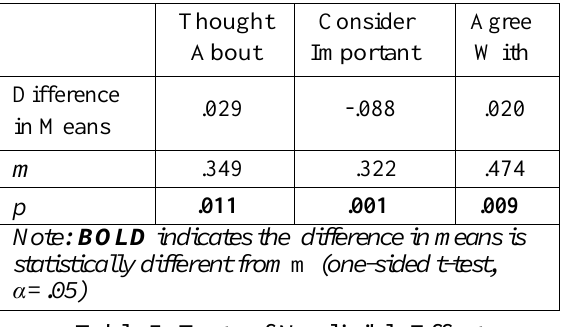
Table 5: Tests of Negligible